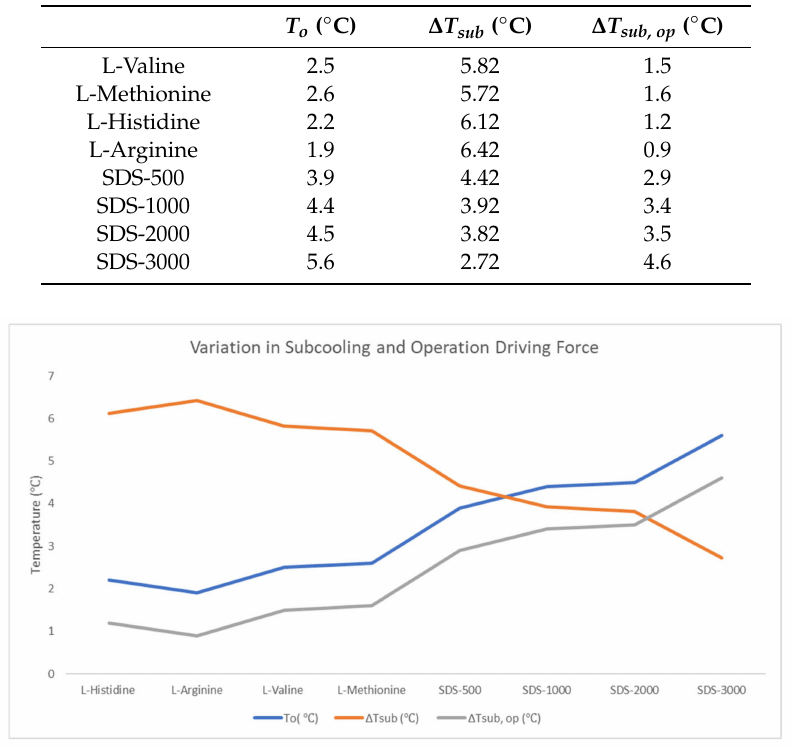
Figure 5. Variation in nucleation temperature and subcooling for Gas B and Sand B for di ff erent